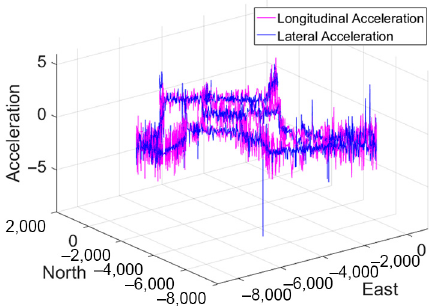
Figure 5 Longitudinal and lateral acceleration